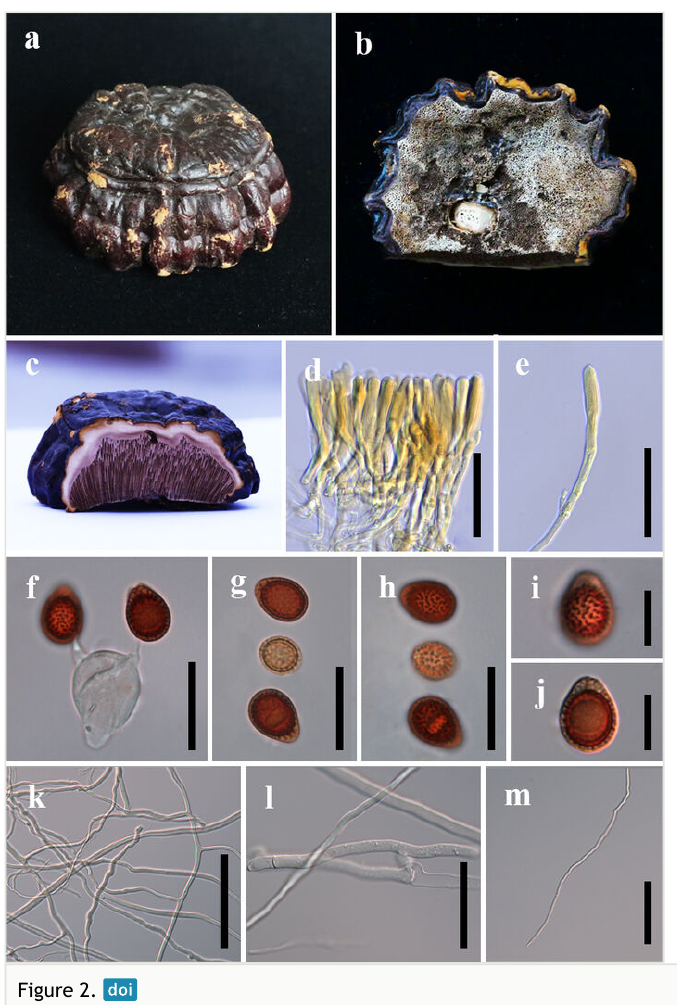
Ganoderma sandunense (GACP18012501, holotype). a Basidiome; b Pore surface; c Sections of pileus; d – e Pileipellis terminal cell; f Basidia; g – j Basidiospores; k Skeletal hyphae and binding hyphae; l Generative hyphae; m Binding hyphae. Scale bars: d–e= 50 μ m; f–h = 20 μ m; i–j = 10 μ m; k = 100 μ m; l–m = 50 μ